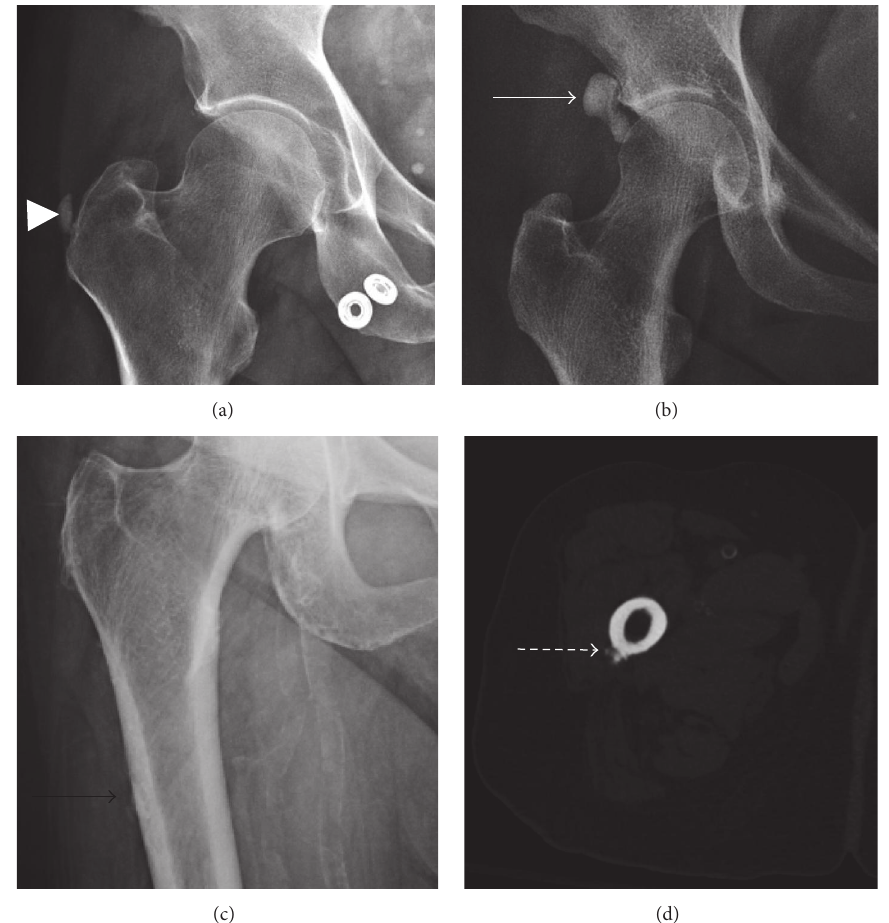
Figure 13: Calcific tendinopathy of the hip. (a) Gluteus medius/minimus calcific tendinopathy (arrow head) is best appreciated on AP hip or pelvis radiographs. (b) Rectus femoris calcific tendinopathy most commonly presents lateral to the acetabular weight-bearing surface (solid arrow). (c) and (d) Calcific tendinopathy of the gluteus maximus tendon. The gluteus maximus tendon calcification almost always involves the tendon insertion on the gluteal tubercle along the posterolateral subtrochanteric femur (black arrow). Cortical erosion and periosteal reaction are frequently seen (dashed arrow), which can easily be mistaken for a juxtacortical